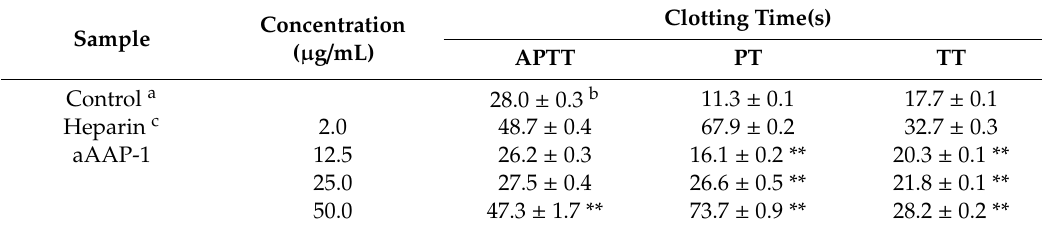
Table 3. Anticoagulant activity of aAAP-1.